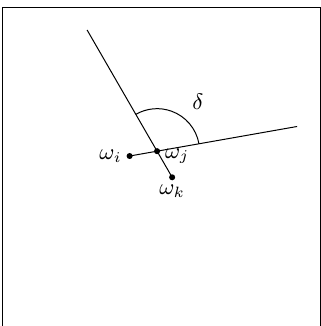
Figure 4: The angle defined by three successive